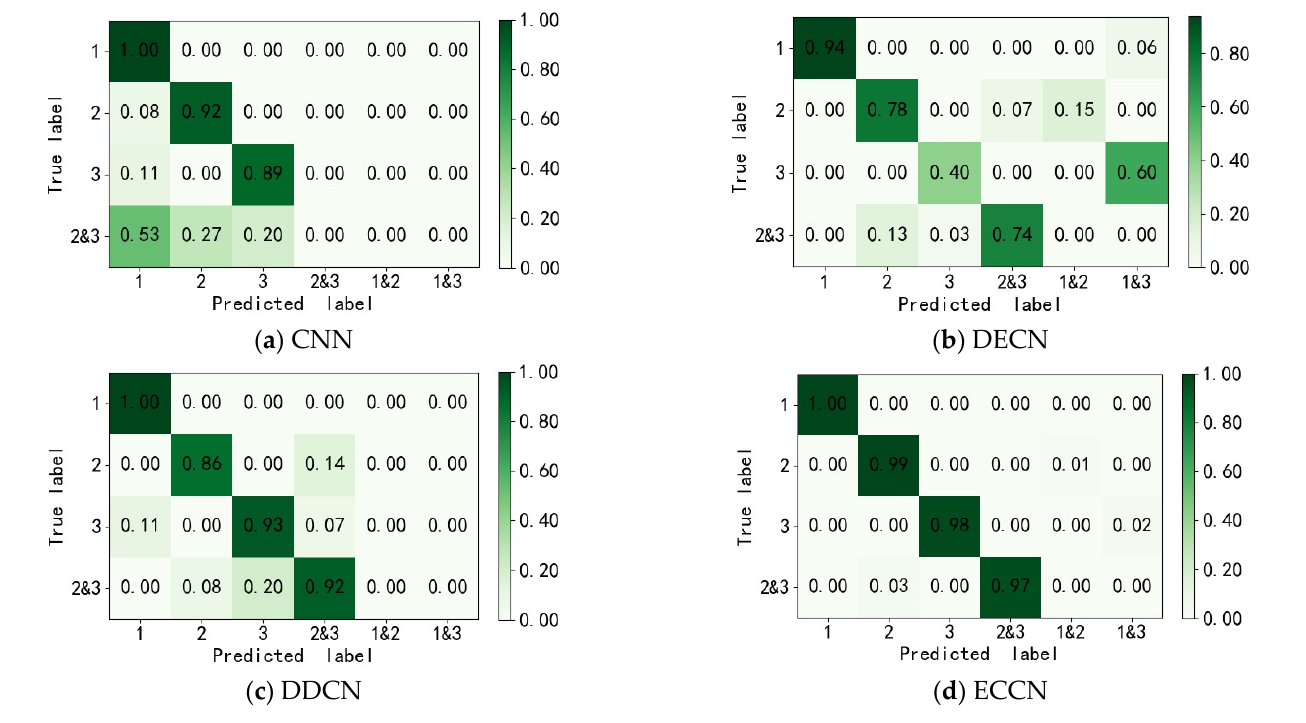
Figure 12. RV reducer data classification confusion matrix ( a ) CNN; ( b ) DECN; ( c ) DDCN; ( d ) ECCN.